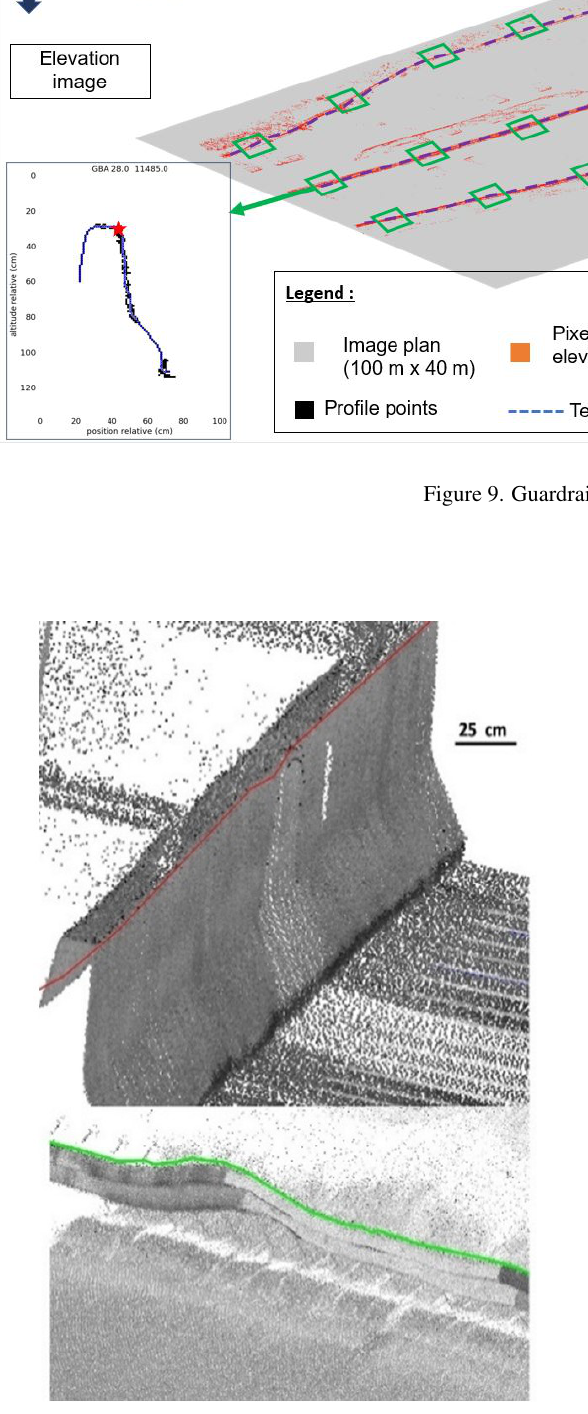
Figure 10. Results of the guardrail vectorization.